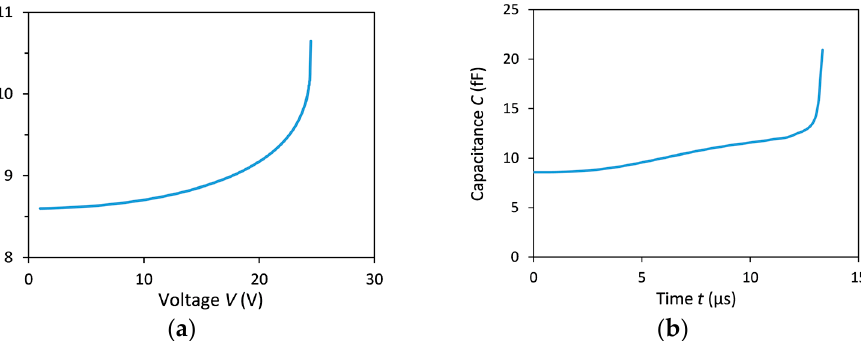
Figure 10. ( a ) Capacitance as a function of actuation voltage, revealing nonlinear rising. ( b ) Capacitance as a function of time, also revealing nonlinear rising. A voltage step function is considered, with a step from zero to 22.2 V occurring at t = 0. The simulation includes temporally rising voltage as well as the bending dynamics of the cantilever.